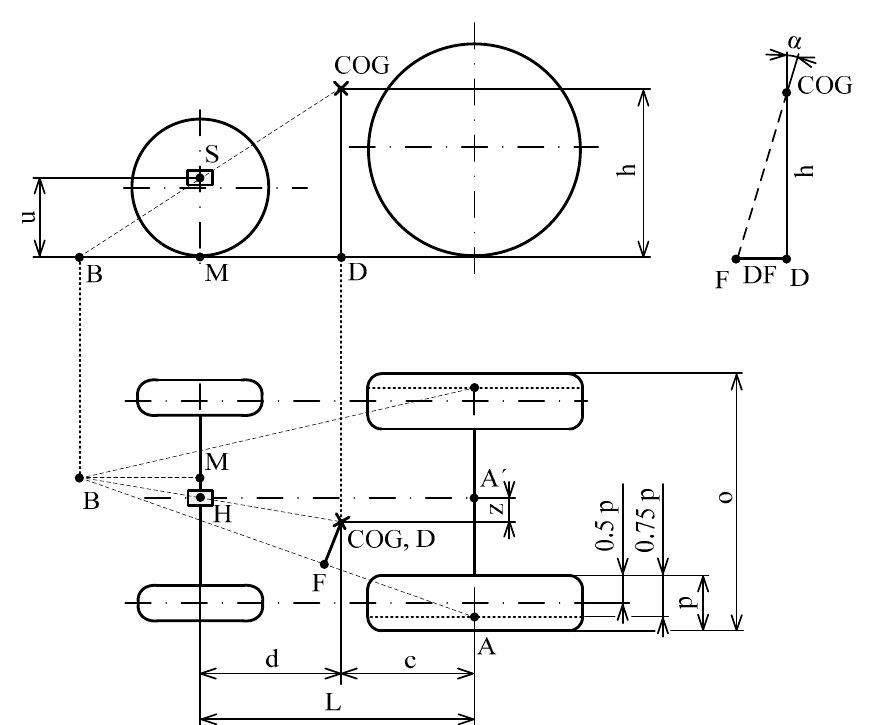
Figure 4. Determination of tractor lateral stability according to standard [12]: o —overall width on tyres of the fixed axle, p —width of tyres on fixed axle, u —height of pivot point of the swelling axle, L —wheelbase, c, d —longitudinal coordinates of COG; h —vertical coordinate of COG; z — lateral position of COG; α —static overturning angle, AA´— base line of stability triangle , DF— slope line.